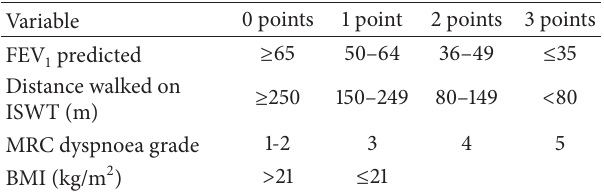
Table 1: Variables and point allocation used for the computation of the i-BODE